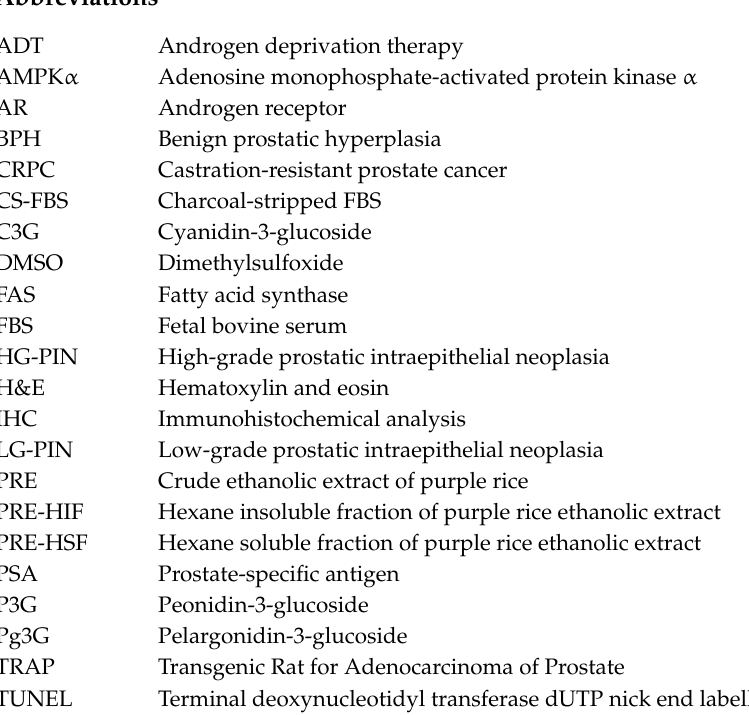
Figure S1: E ff ects of PRE-HIF on caspase and cleaved caspase expression. Figure S2: E ff ects of PRE-HIF on the rat CRPC cell line, PCai1, under completely hormone-depleted conditions (10% CS–FBS supplemented